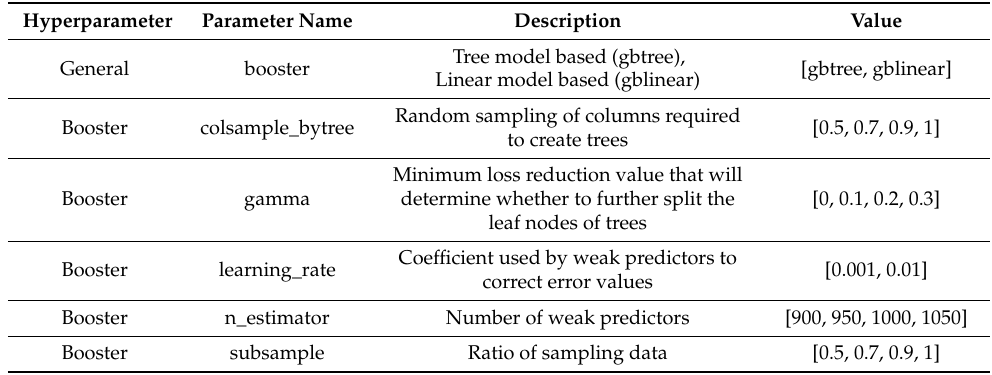
Table 4. Description of hyperparameters.